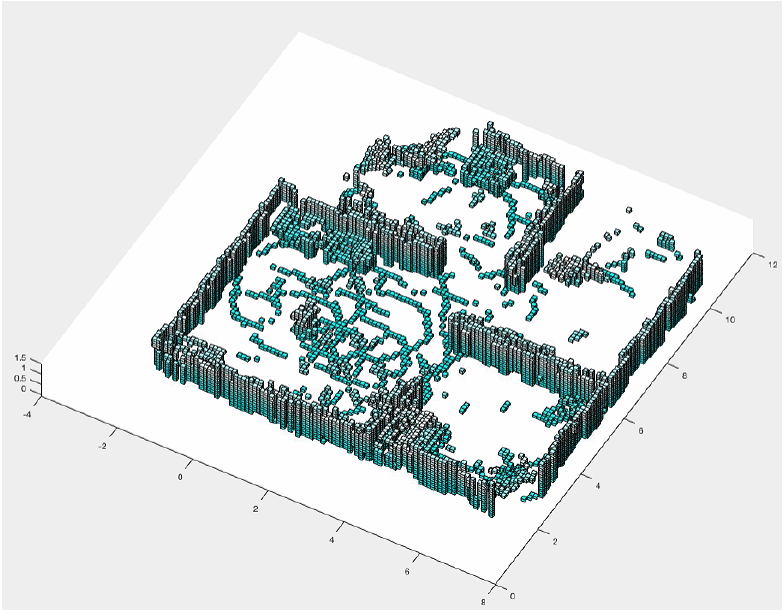
Figure 15. Three-dimensional cube view.